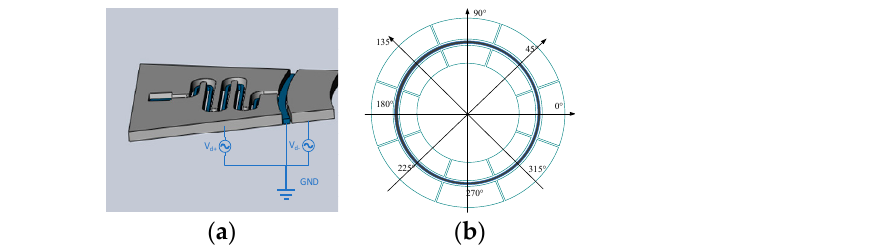
Figure 5. Schematic diagram of the resonant ring circuit: ( a ) The equivalent capacitance; ( b ) electrode distribution.